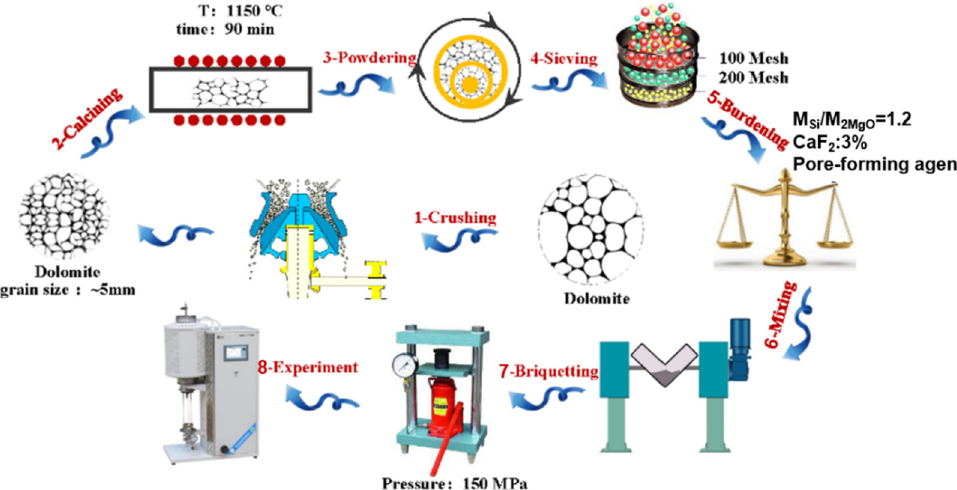
Figure 1. The craft of pellet preparation.